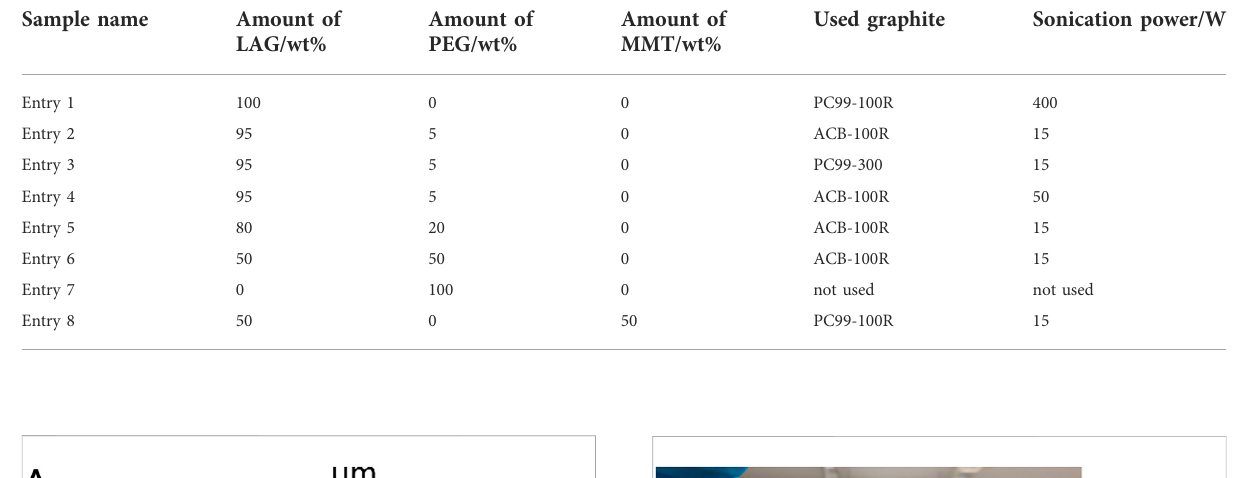
TABLE 1 Preparation conditions of the LAG samples.